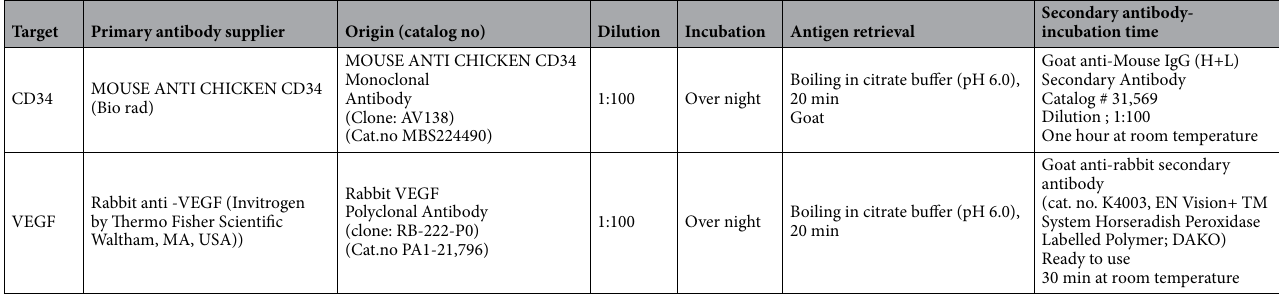
Table 3. Identity, sources, and working dilution of antibodies used in immunohistochemical studies. Antibodies used that showed reactivity in Avian